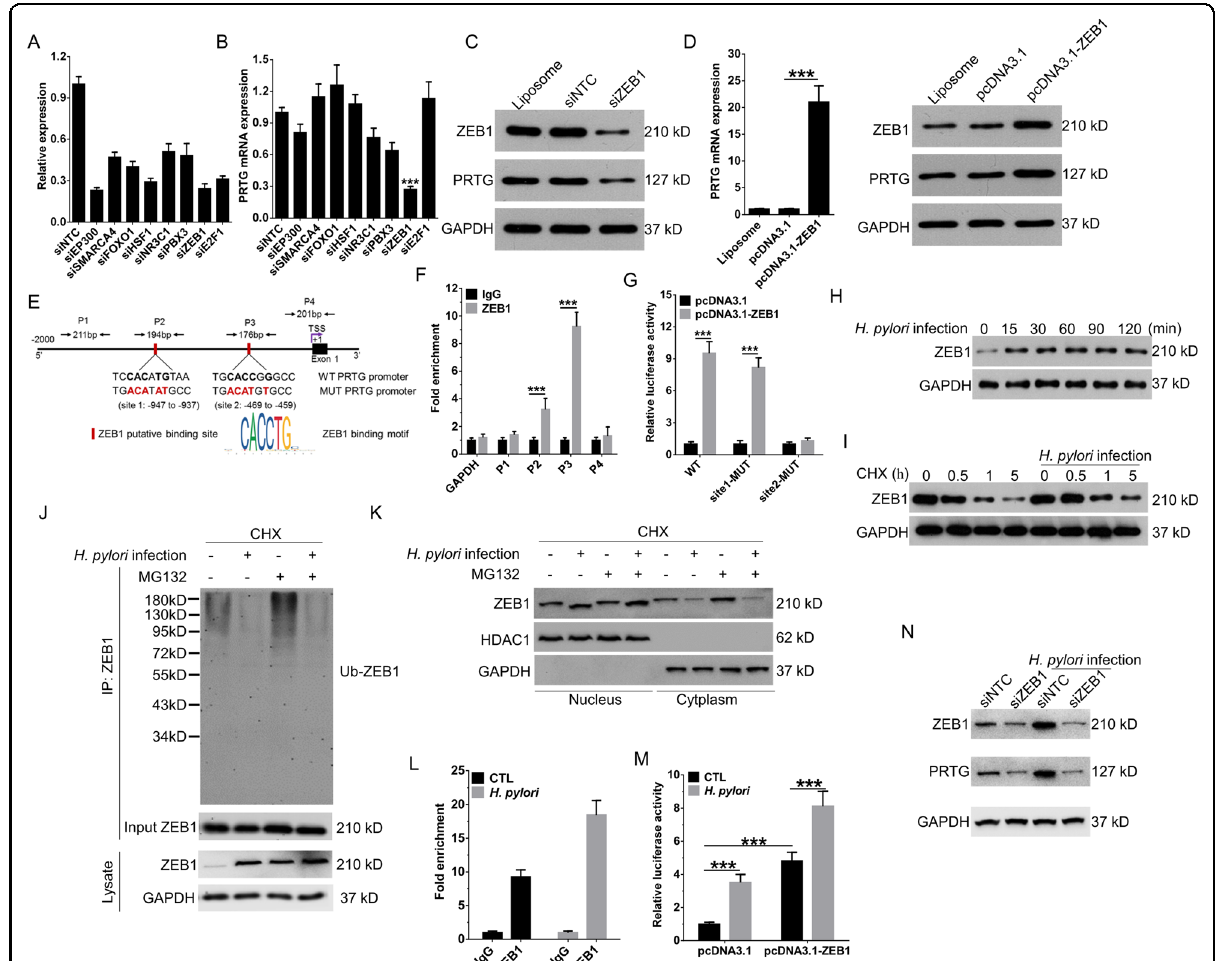
Fig. 4 H. pylori promotes ZEB1 stabilization and recruitment to PRTG promoter. A qRT-PCR was used to detect the silencing ef fi ciency of siRNA targeted to corresponded transcription factor in AGS cells. Relative expression meant the expression of siRNA targeted transcription factor refer to the expression level of cells transfected with control siRNA. B The expression of PRTG in AGS cells transfected with indicated siRNA targeted to corresponded transcription factor was detected by qRT-PCR. C The expression of ZEB1 and PRTG in ZEB1 silencing AGS cells were detected by western blot. Liposome represented transfection regent control. D qRT-PCR and western blot were used to the expression of PRTG and ZEB1 in AGS cells transiently transfected with pcDNA3.1 empty vector or pcDNA3.1-ZEB1. E Predicted binding sites of the transcription factor ZEB1 to PRTG promoter (site 1 and site 2). P1 and P4 represented distal regions far from ZEB1 predicted binding sites in PRTG promoter. F The binding site of